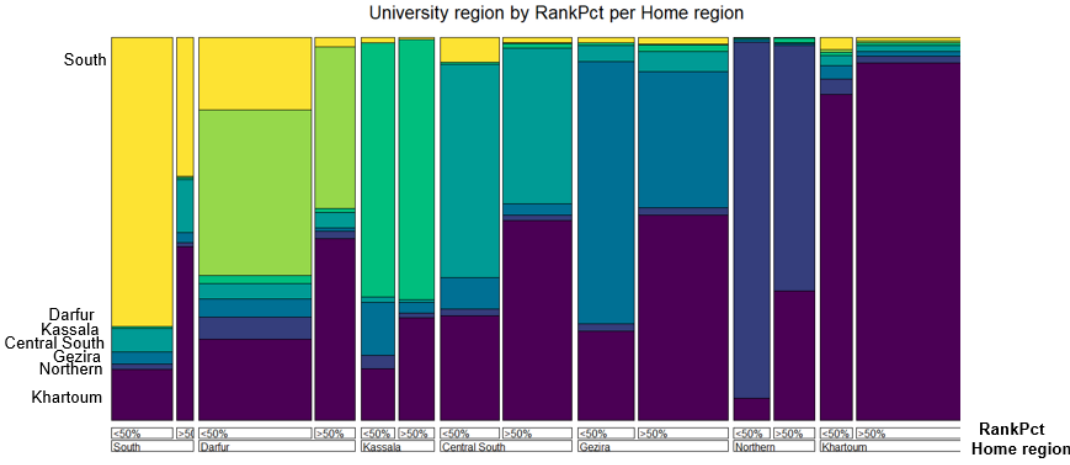
Figure 18. Double-decker plot showing the proportion of students attending universities in different regions according to home region for below average (<50%) and above average (>50% ) 2016–2017 incoming bachelor’s